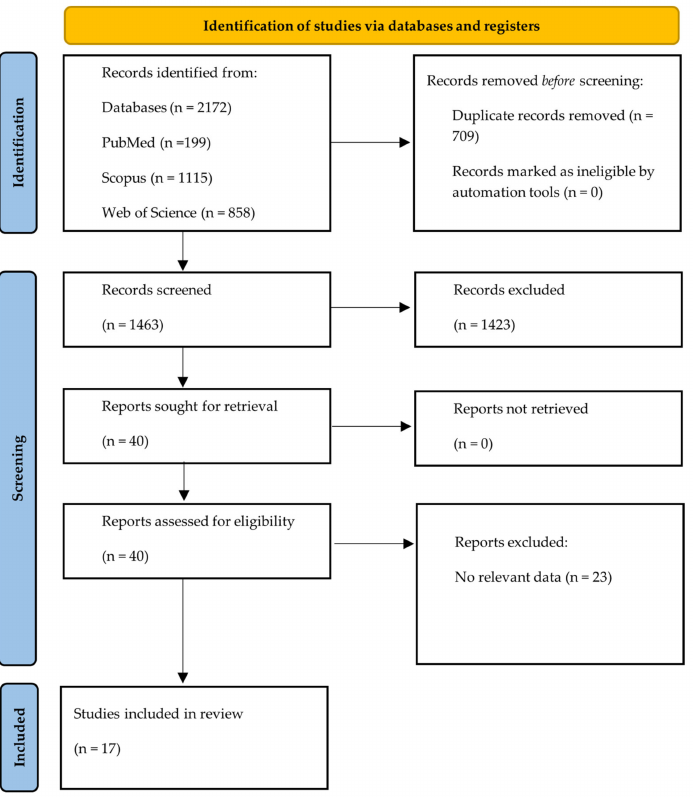
Figure 2. PRISMA flow diagram of the study research methodology in the literature. This literature review spotlighted only clinical studies focusing on sex differences and Tryp metabolism for neu- rological conditions and excluded reviews, meta-analyses, and systematic reviews or unavailable as complete articles. Further, this research only included original English-written articles from the past 20 years. Articles referred as “no relevant data” did not allow us to draw conclusions regarding sexual dimorphisms (the two biological sexes were not divided as independent groups and/or a direct statistical comparison between sexes was not